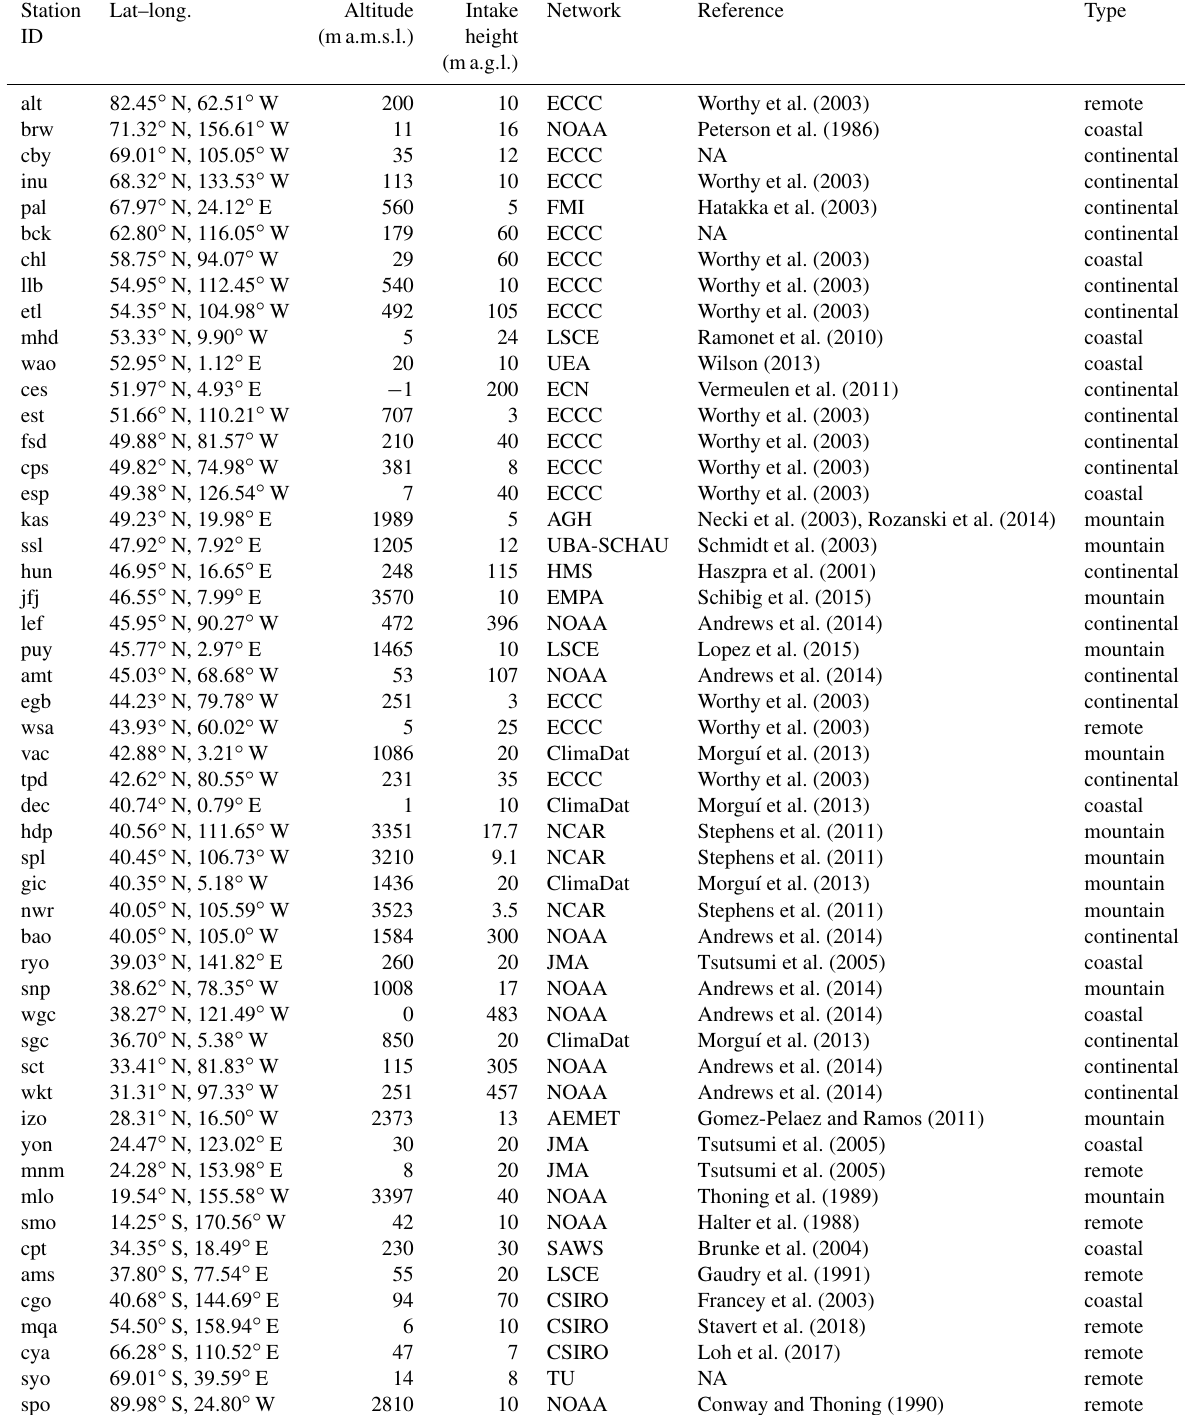
Table A1. Continuous in situ stations (surface and tower) used to evaluate synoptic variability. NA denotes references that are not available. The full names for the abbreviations of the network organisations are provided in Table